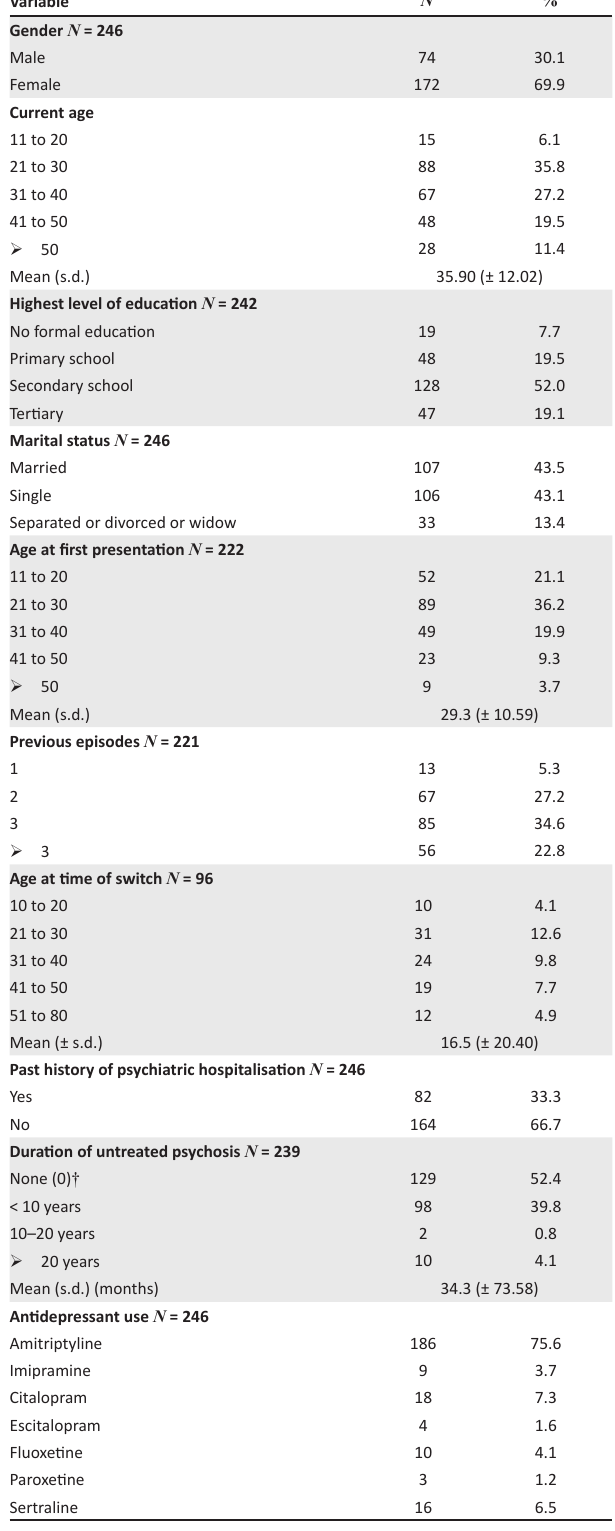
TABLE 1: Socio-demographic and clinical